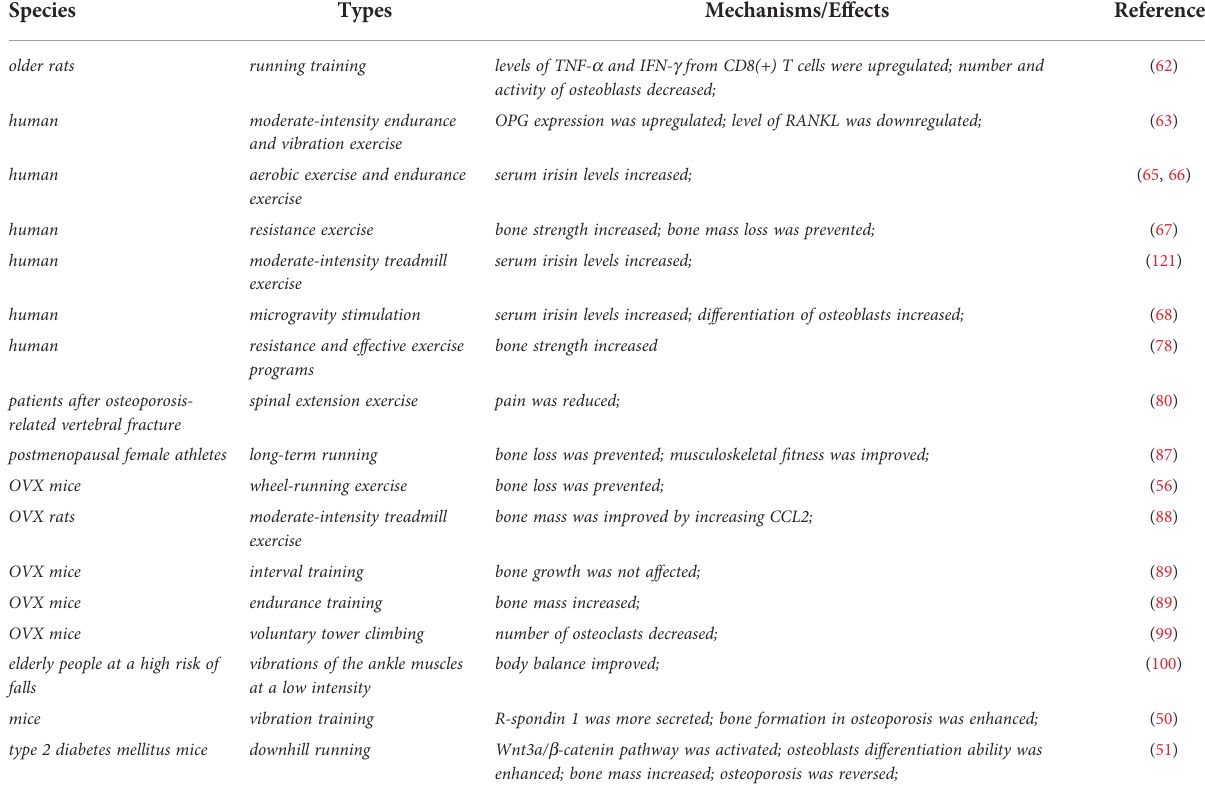
TABLE 1 Recommendation for